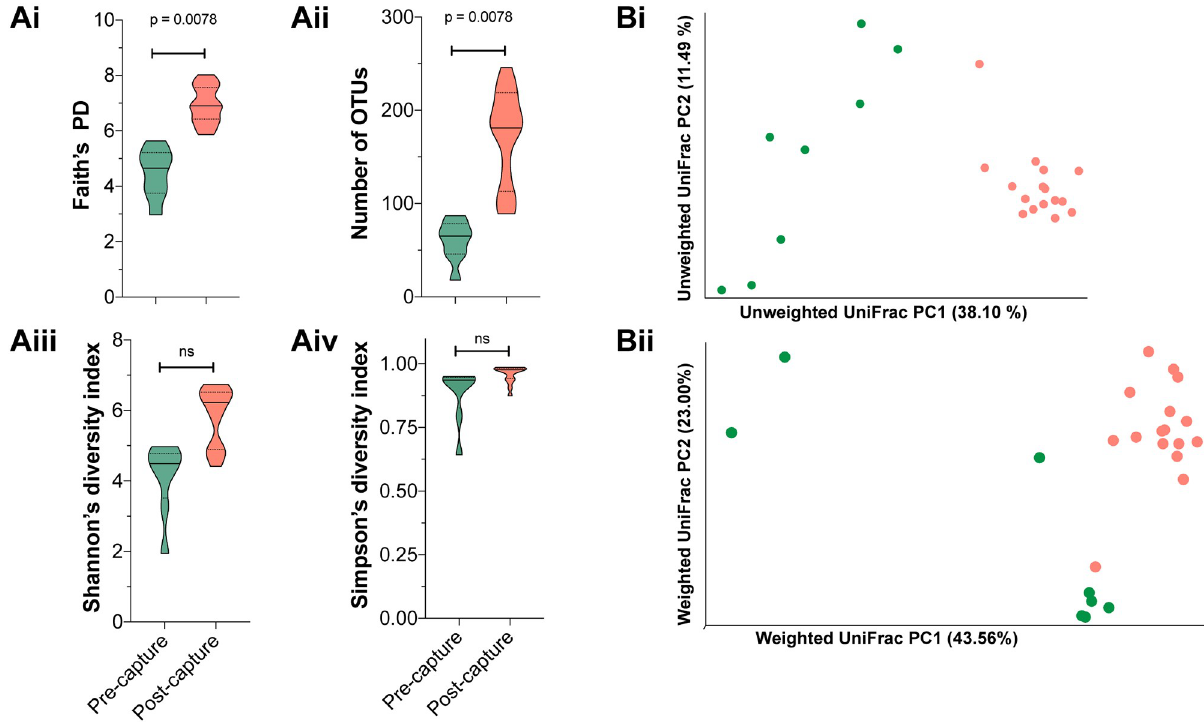
Fig 2. Alpha and beta diversity metrics for pre-capture and post-capture datasets. With violin plots several alpha diversity metrics are shown in A including: i. Faith’s phylogenetic diversity (PD) score ii. the number of OTUs iii. Shannon’s diversity index and iv. Simpson’s diversity index for OTU mapped 16S rRNA gene sequences amplified from pre-capture (green) and post-capture (light-red) fecal samples. The median and quartiles for the different scores are shown for nine pre-capture bats (green) and 16 post-capture bats (light-red). The beta diversity of microbial communities in each pre-capture (green) and post-capture (red) sample was calculated with unweighted UniFrac ( Bi ) and weighted UniFrac ( Bii ) and scaled values are shown with a PCoA plot visualized with Qiime2view.